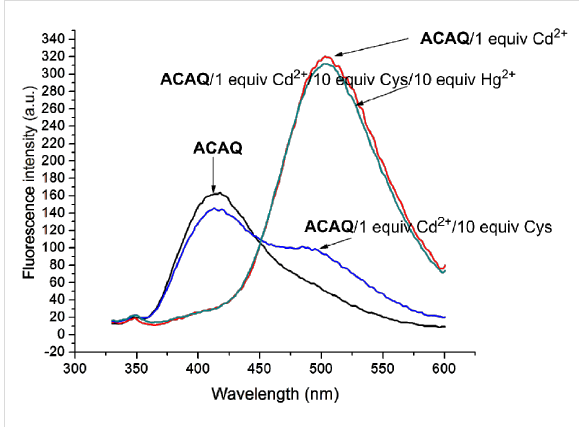
ter), the reversible binding of Cys and the probe must be estab- Cd 2+ – ACAQ can be fully recovered when 10 equivalents of Hg 2+ , which is a scavenger of Cys, was